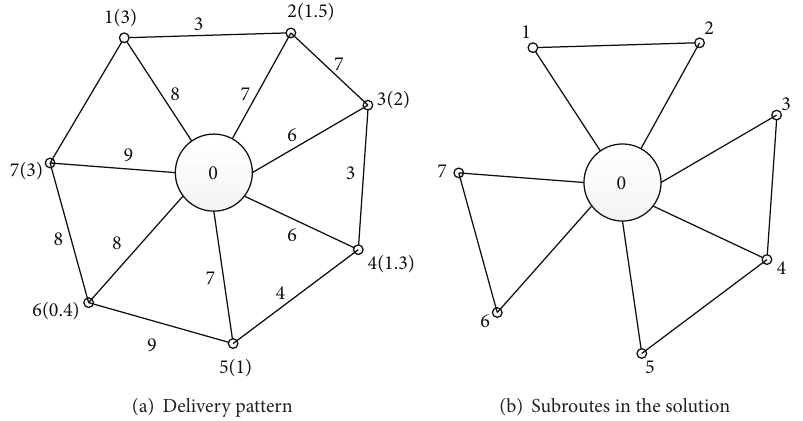
Figure 1: The example VRP.